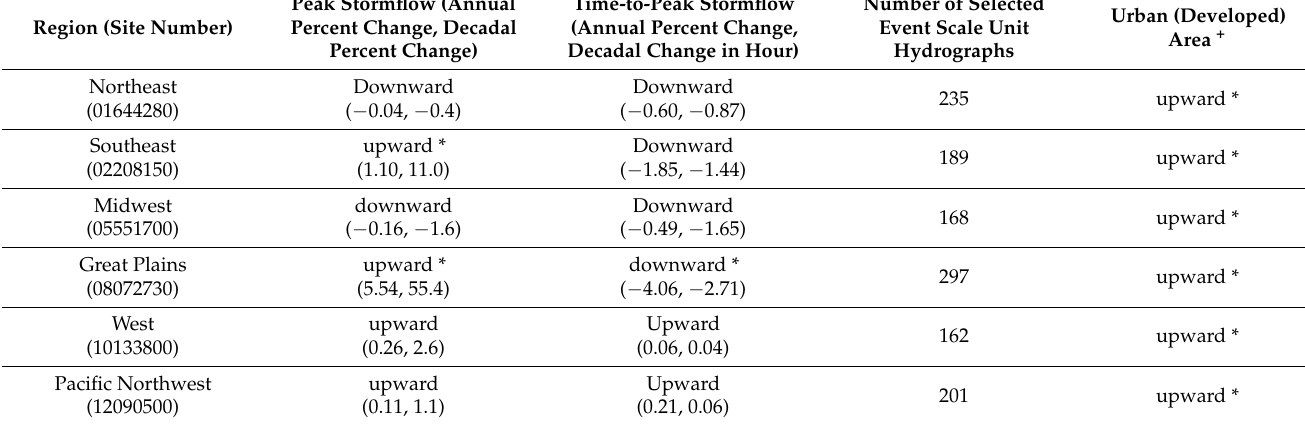
Table 2. Trends in peak stormflow, time-to-peak stormflow, and urban (developed) area. Upward or downward trends are based on the positive or negative slopes of trend lines, respectively. The annual percent change of increase (positive values) or decrease (negative values) in peak stormflow (second column) and time-to-peak stormflow (third column) at each watershed is computed as a ratio of slopes of trend lines divided by their respective average values during the study years. The annual percent change in peak stormflow was multiplied by 10 to obtain the expected decadal percent change in peak stormflow (second column). The slopes of trend lines of time-to-peak stormflow were multiplied by 10 to compute expected changes in decadal time-to-peak stormflow (third